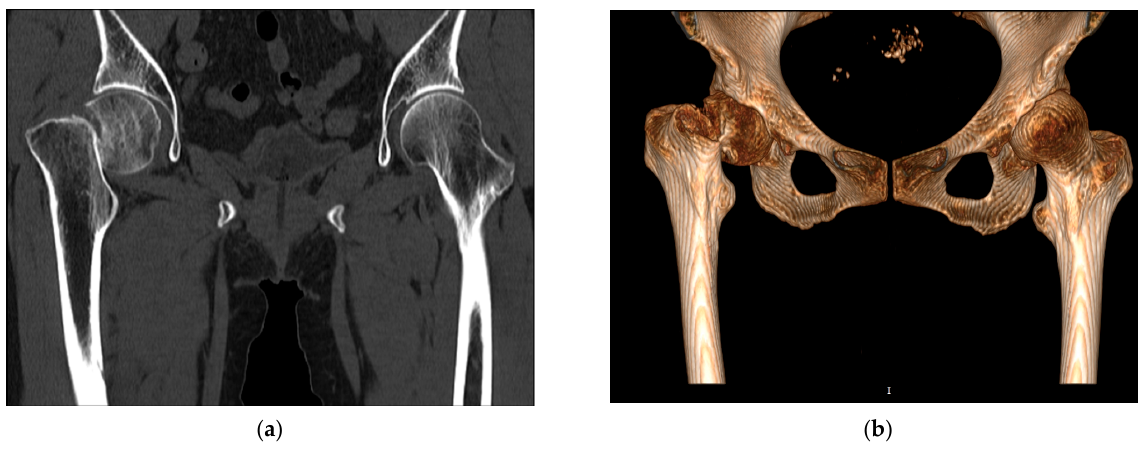
Figure 1. Intracapsular fracture occurring because of low-energy falls in the elderly: ( a ) CT diagnostic image; ( b ) 3D reconstruction model.